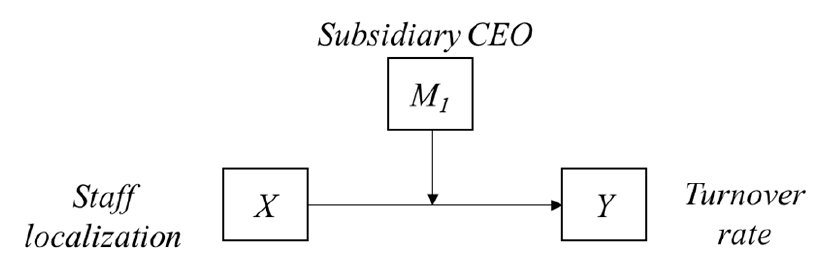
Figure 1. The theoretical research model (made by author, 2022) Research Model.